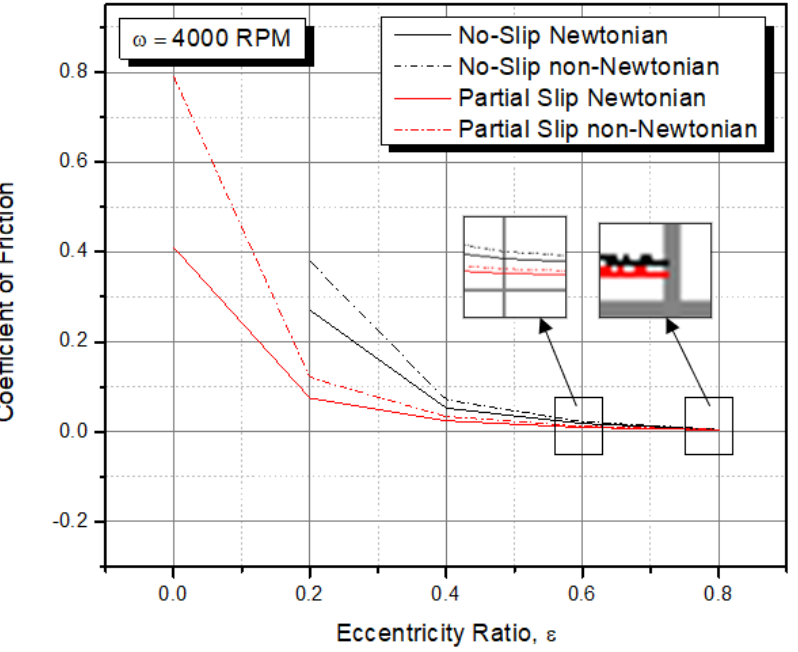
Figure 12. Coefficient of friction versus eccentricity ratios for different cases.